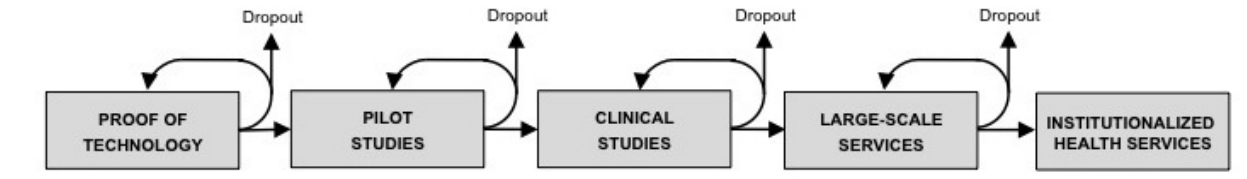
Figure 1. Implementation process of telemedicine applications.